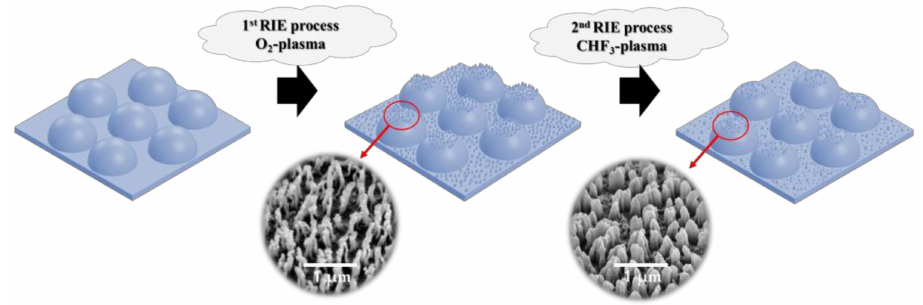
Figure 1. RIE process.